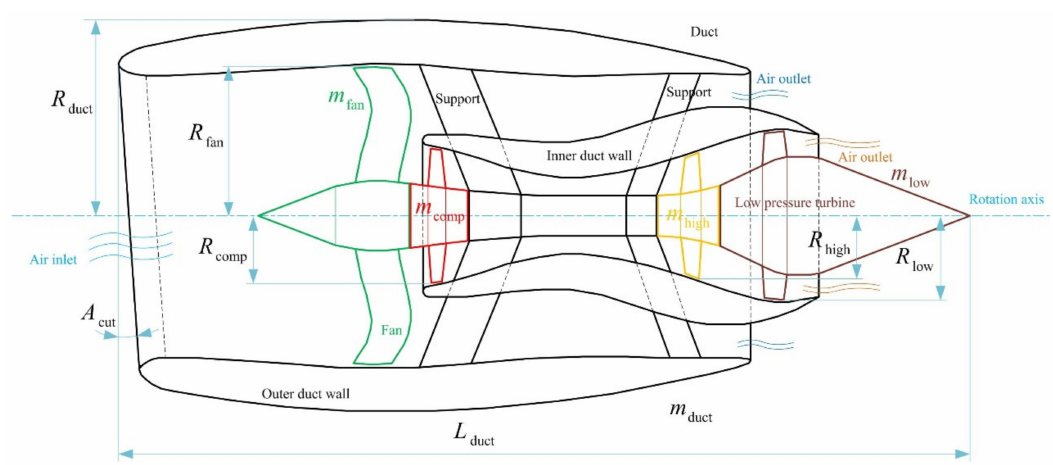
Figure 3. Geometric configuration of a turbofan engine with full factorial design (FFD).